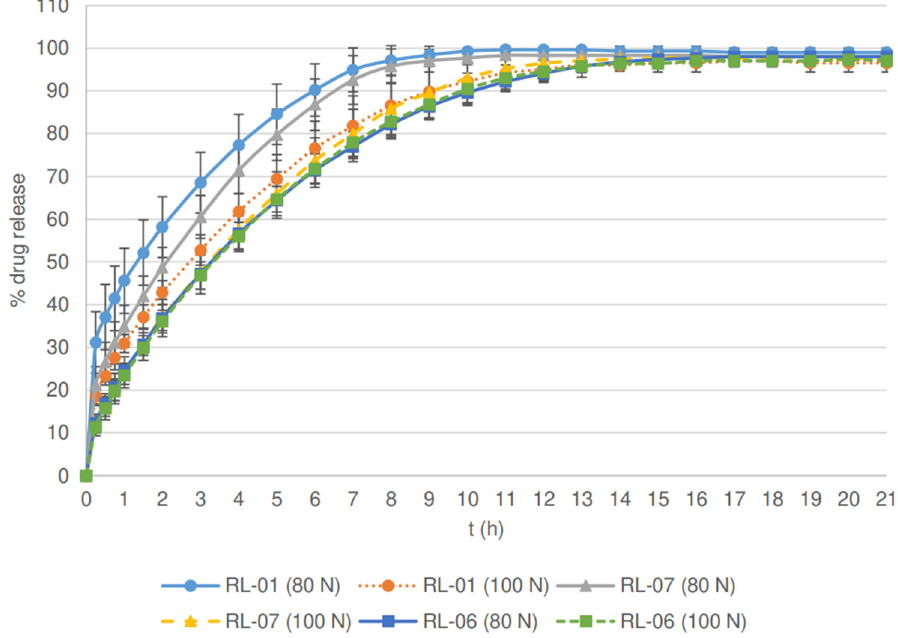
Figure 2. Effect of particle size distribution and tablet hardness on % drug release from matrix tablets containing lactose as a filler.